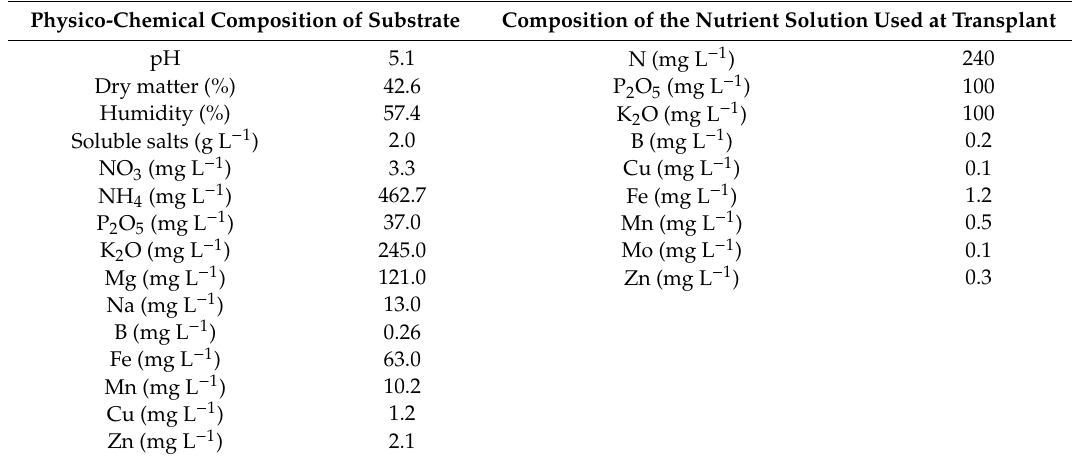
Table 1. Composition of the substrate and of the nutrient solution used for the experiment. Physico-Chemical Composition of Substrate Composition of the Nutrient Solution Used at Transplant